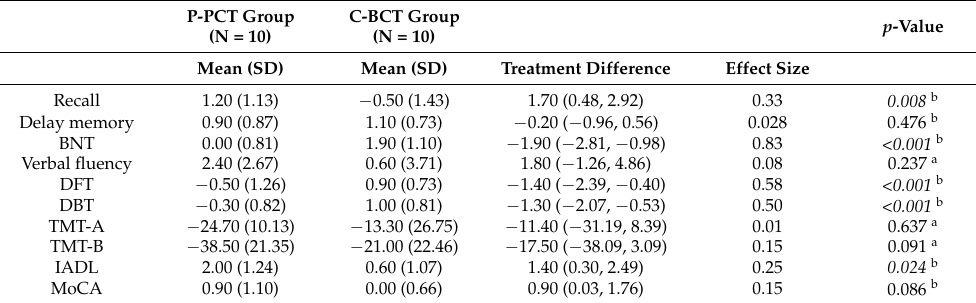
Table 4. Effect of the intervention in the P-PCT group compared to the C-BCT